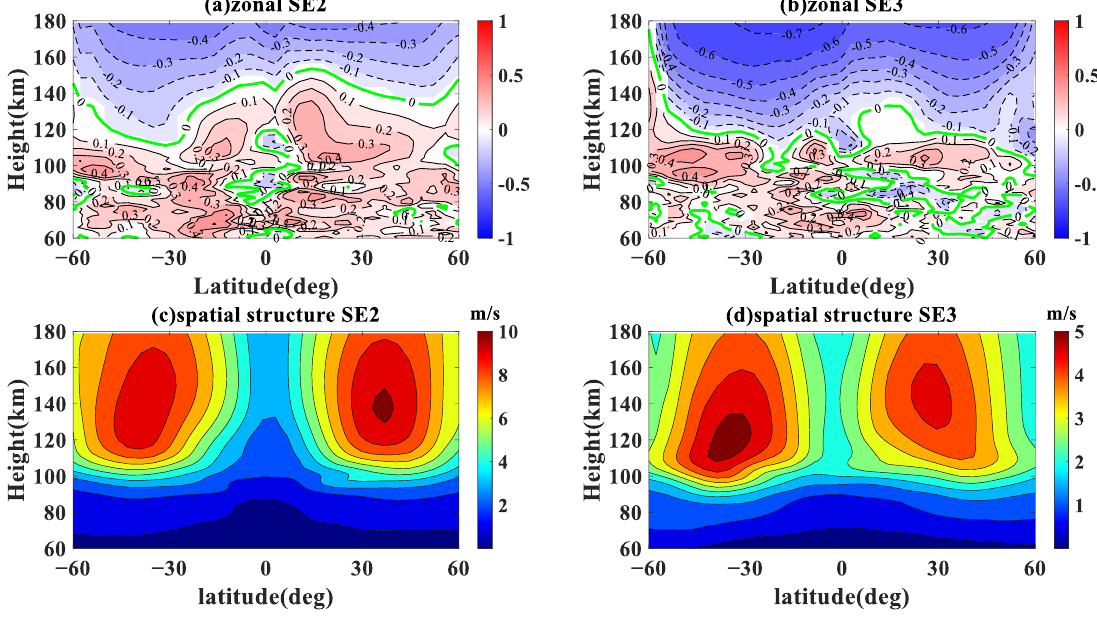
Figure 3. The correlation between non-migrating tidal variations ( a ) DE2 and ( b ) DE3 and F10.7 cm index between 60 ° S and 60 ° N from 2003 to 2019. The spatial structure between 60 ° S and 60 ° N from 2003 to 2019 for ( c ) DE2 and ( d ) DE3. from 2003 to 2019 for ( c ) DE2 and ( d )